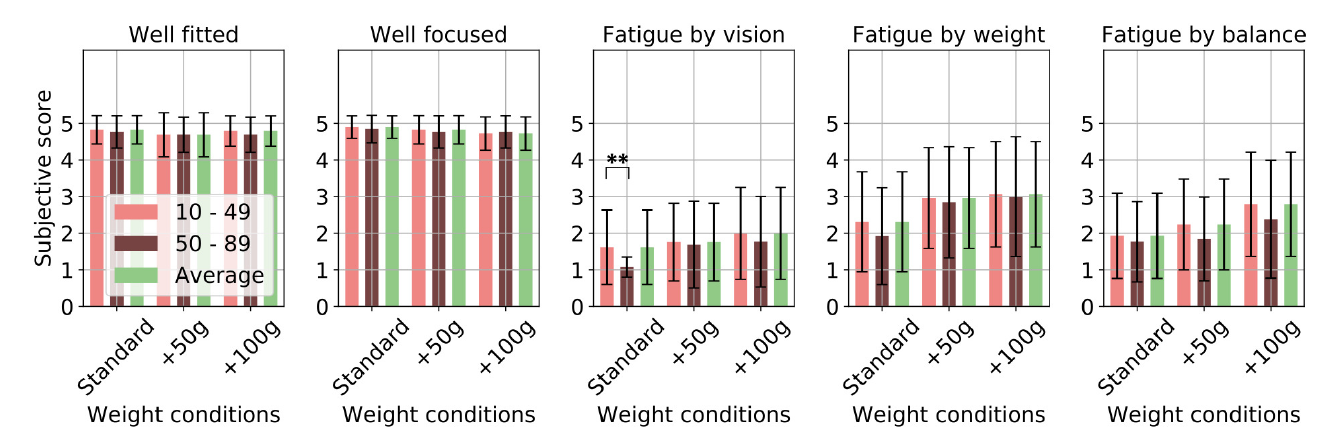
Figure 6. Questionnaire results for male participants in the “both” group. The results of Q1 to Q5 are shown from left to right. (*: p < 0.05, **: p < 0.01).